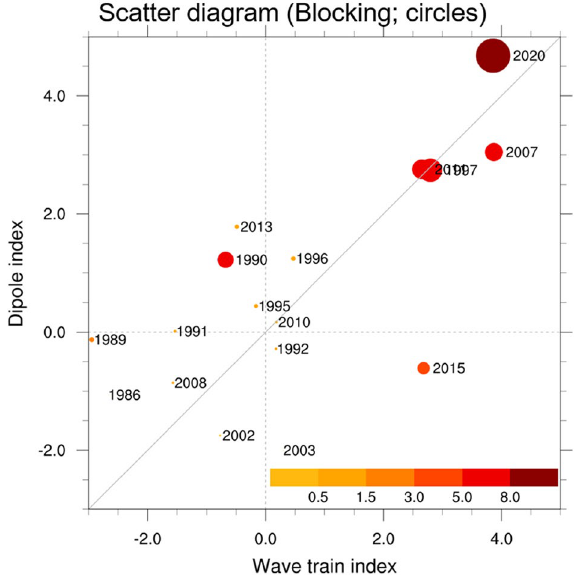
Figure 3. Comparison between April 2020 and normal years on the atmospheric circulation linked to the cold condition. Scatter diagram of the wave train index ( x -axis) under dipole index ( y -axis) and blocking index (circles) during April 1982–2020, except for the year with a zero-blocking index (i.e., non-blocking). Each circle’s size and color (from yellow to red) denote the magnitude of the blocking index, indicating the blocking frequency in Siberia. Each year is presented on the right side of the